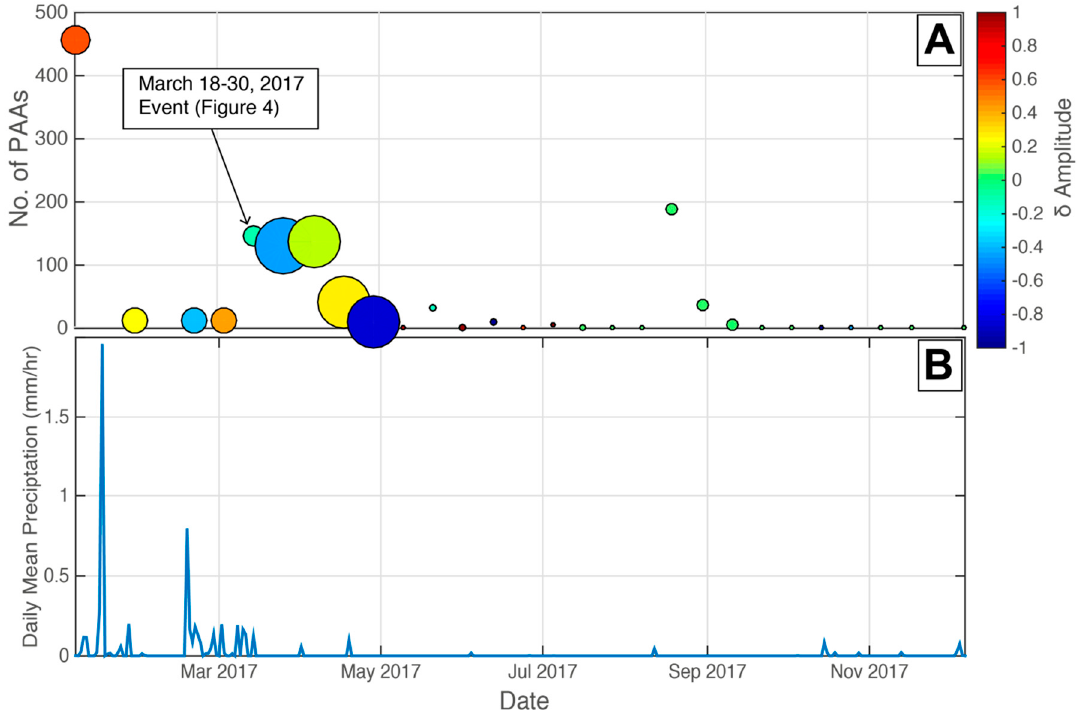
Figure 6. Comparison of the number of potentially affected areas detected in the Quebrada del Toro ( A ) to regional rainfall as recorded by the Global Precipitation Mission ( B ). ( A ) The number of PAAs detected per time interval, with symbol sizes scaled linearly to the largest contiguous PAA for a given date (dates with no PAAs detected were given an arbitrarily small symbol size). We hypothesise that large contiguous PAAs are likely the result of soil moisture changes rather than potential land surface movements (e.g., debris flows, mudflows). The change in amplitude between scenes is used as a proxy for changes in soil moisture, where negative δ Amplitude suggests increased soil moisture. Dates with smaller maximum PAA area and δ Amplitude ≈ 0 are more likely to contain PAAs unrelated to soil moisture change.